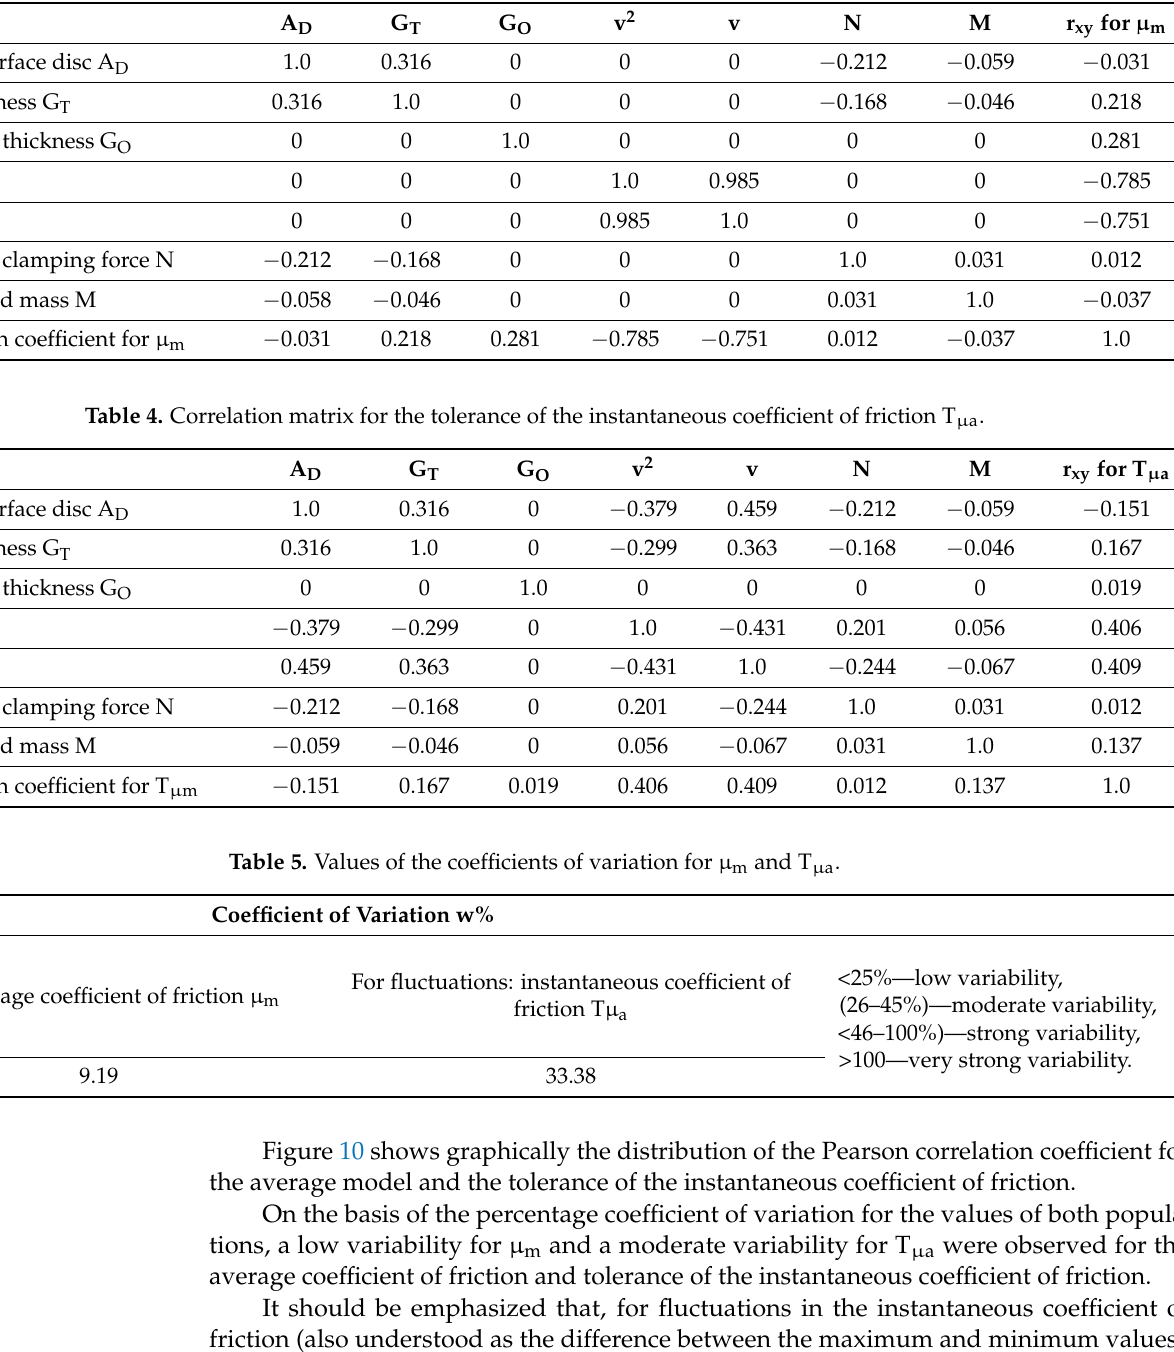
Table 3. Correlation matrix for the average coefficient of friction µ m .